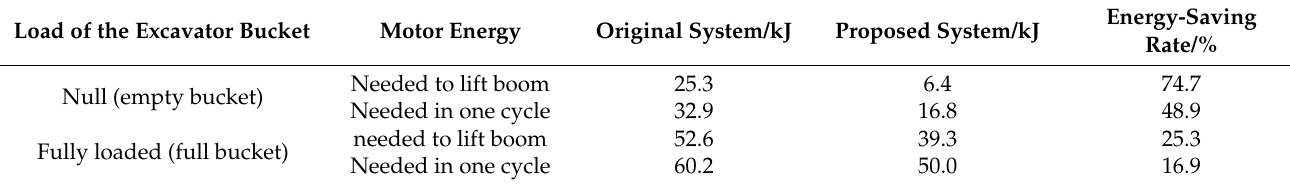
Table 2. Summarization of energy-saving